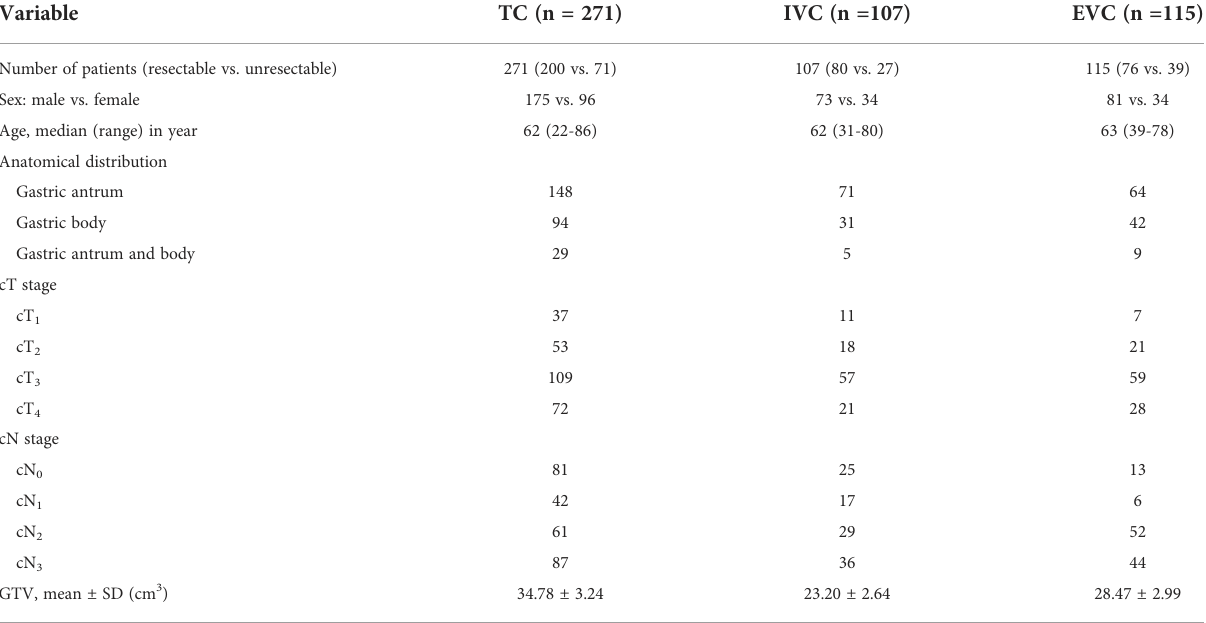
TABLE 1 Clinical information in the training cohort, and internal and external validation cohorts. Variable Number of patients (resectable vs.